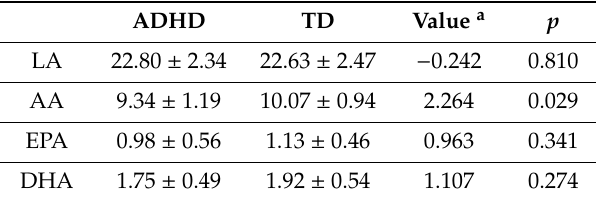
Table 2. Blood fatty acids analysis